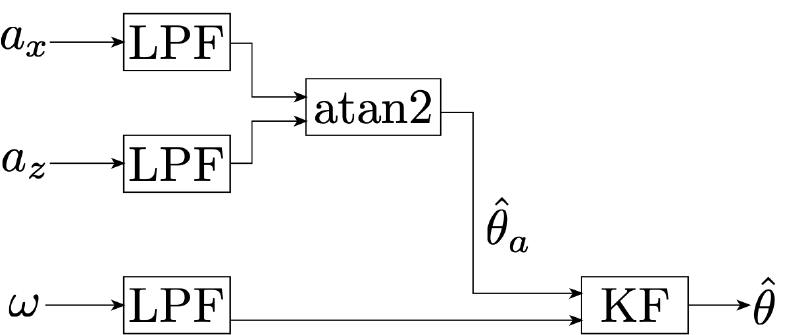
Figure 7. Flow chart outlining the process used to derive the pedal angle. After passing the analysis- relevant signals through second order Buttwerworth low-pass filter (LPF), we compute a rough estimate of the pedal angle based on accelerometer measurements ˆ θ a and then fuse the gyroscope measurements ω with ˆ θ a using a KF to get a refined version of the estimate ˆ θ